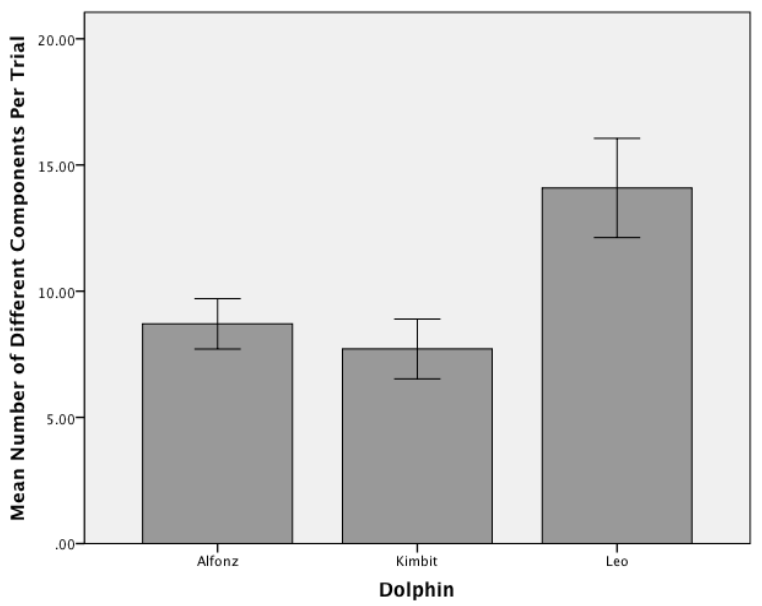
Figure 4 . Mean number of different components per trial for each